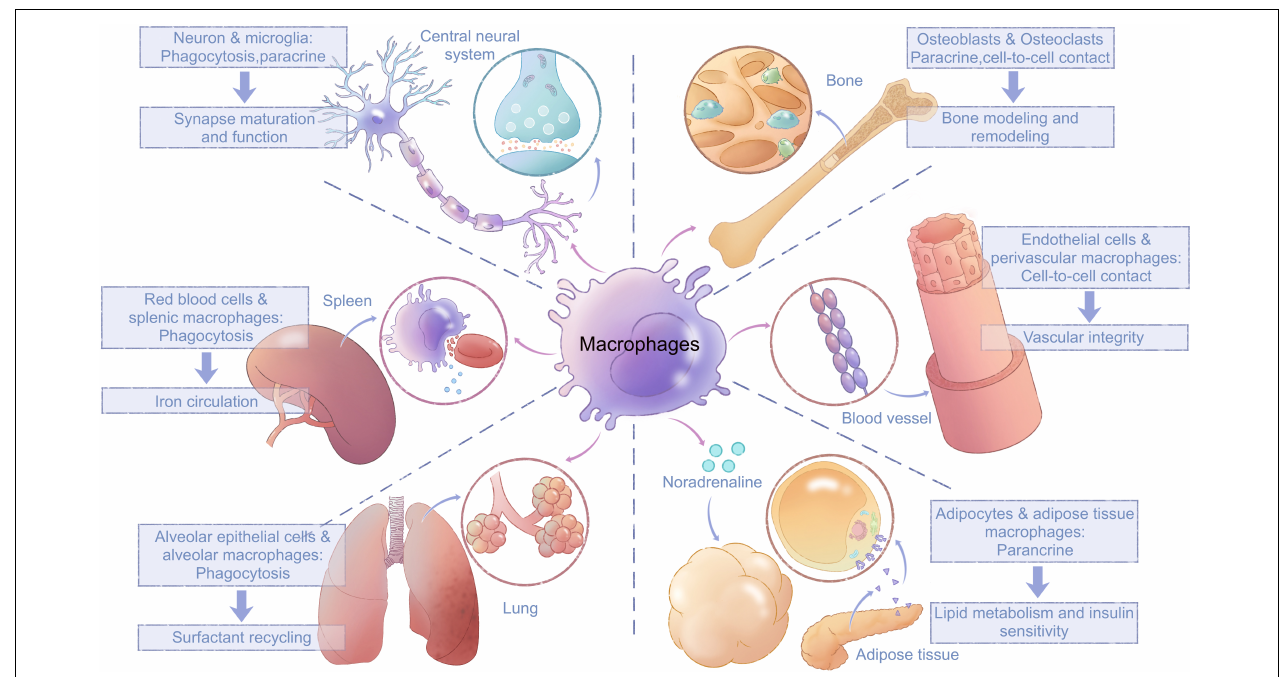
FIGURE 3 | Interactions between macrophages and tissue cells. Macrophages interact closely with surrounding tissue cells through paracrine mechanisms, cell-to-cell contacts, and direct phagocytosis; these interactions are vital for tissue development and their normal function. Microglia trim synapses and release signal molecules to promote neural synapse maturation and function. Splenic macrophages phagocytose red blood cells and facilitate iron circulation. Alveolar macrophages phagocytose surfactants produced by alveolar epithelial cells. Bone-resident osteoclasts interact with osteoblasts through both cell-to-cell contacts and paracrine communication. Perivascular macrophages maintain vascular integrity by attenuating phosphorylation of VE-cadherin in endothelial cells via cell-to-cell contact. Macrophages in white adipose tissue regulate lipid metabolism and insulin sensitivity in adipocytes via paracrine effects of noradrenalin. VE, vascular